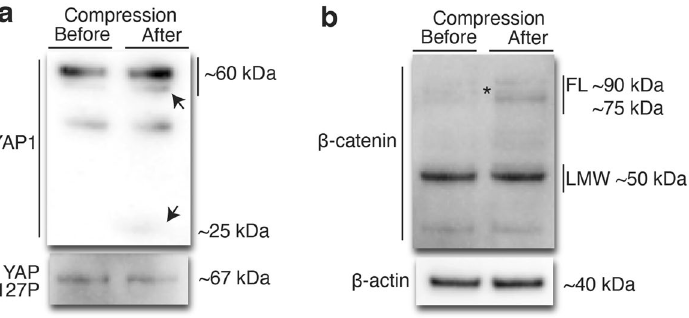
Figure 3. Western blot analysis of lateral compression -induced effects on YAP1 and β -catenin. Epithelial cells were cultured on a pre-strained PDMS membrane in Brick Strex S device until full confluency. Following sequential membrane relaxation and increased lateral compression, the cells were let to recover for 2 h prior to cell lysis and analyzed by western blot (n = 2). ( a ) Expression and phosphorylation (S127P) status of YAP1 and ( b ) expression of β -catenin were analyzed from whole cell lysates of non-compressed (before) and compressed (after) samples (20 µ g of total protein per sample). Arrows indicate the compression-induced cleavage